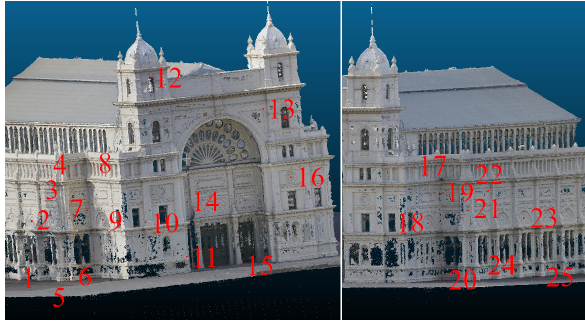
Figure 7. The distribution of 25 points used for the comparison of point cloud coordinates.